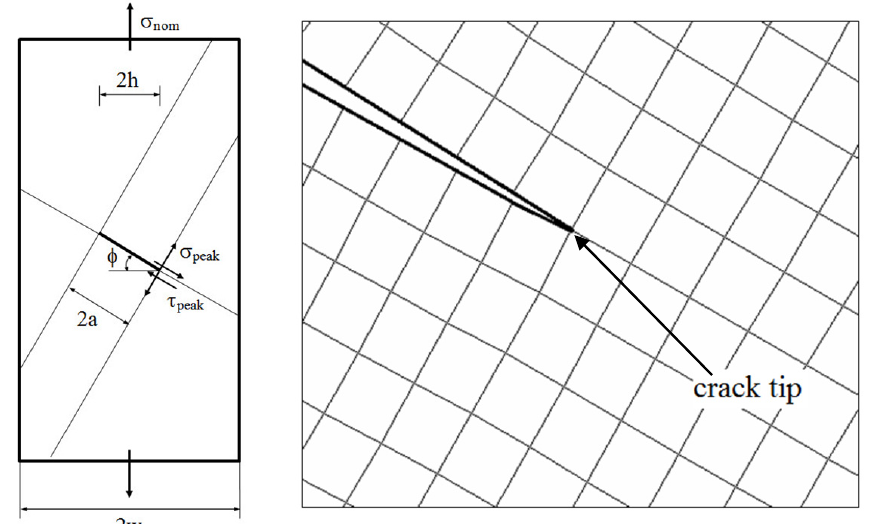
Figure 2: (a) Geometry and loading condition of the analysed mixed mode crack problem. 2W = 200 mm. (b) Pattern of finite elements around the singularity point: four elements share the node located at the crack